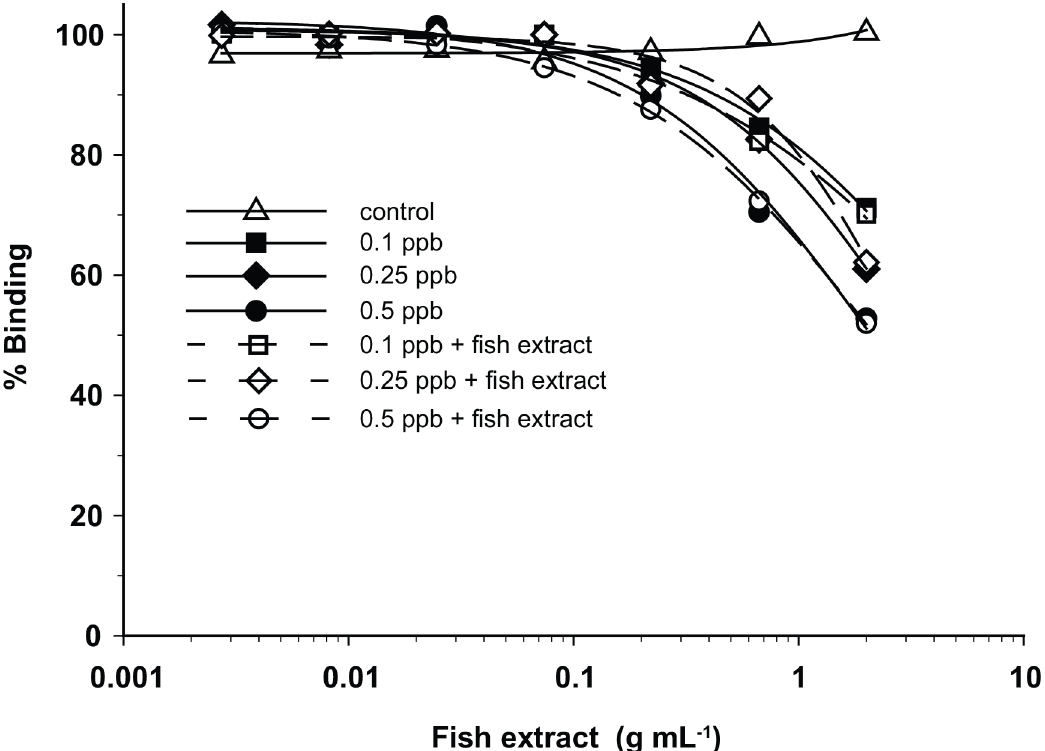
Fig 2. Solid-Phase Extraction Results. Separate 5 g fish extracts from a fish containing no measurable ciguatoxin were spiked to a final concentration of either 0.1 (open squares), 0.25 (open diamonds), or 0.5 (open circles) ppb P-CTX-3C. Comparable buffer samples were similarly spiked with of either 0.10 (solid squares), 0.25 (solid diamonds), or 0.50 (solid circles) ppb P-CTX-3C. The control was tissue extract with no ciguatoxin added. Spiked and control samples were serially diluted 1:3 and results plotted as % binding versus equivalents of fish tissue extracted (g mL -1 ). Results indicated that matrix effects in the fish extracts did not interfere with binding of